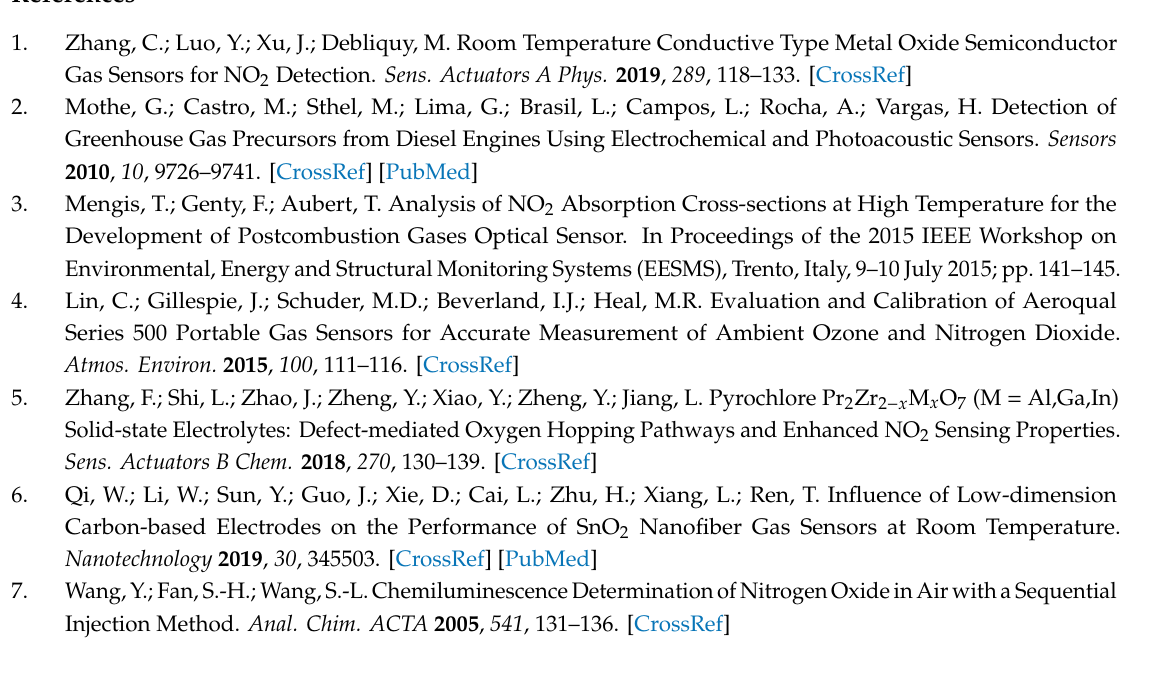
Figure S1: SEM sectional image of sensitive materials, Figure S2: The structure of temperature